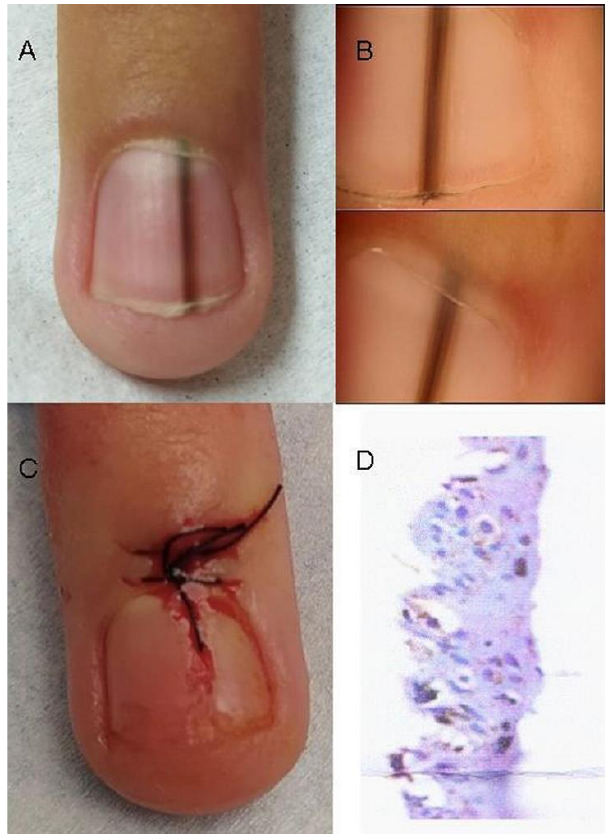
Figure 1 : A) Longitudinal melanonychia of the right fourth digit of a 13-year-old boy. B) Dermoscopy image showing homogeneous brown linear pigmentation and pigment visible through the translucent cuticle and proximal nail fold (pseudo-Hutchinson sign). C) Complete removal of the nail matrix nevus. D) Detail of the histopathological characteristics in the basal and parabasal epidermis with typical nevocellular